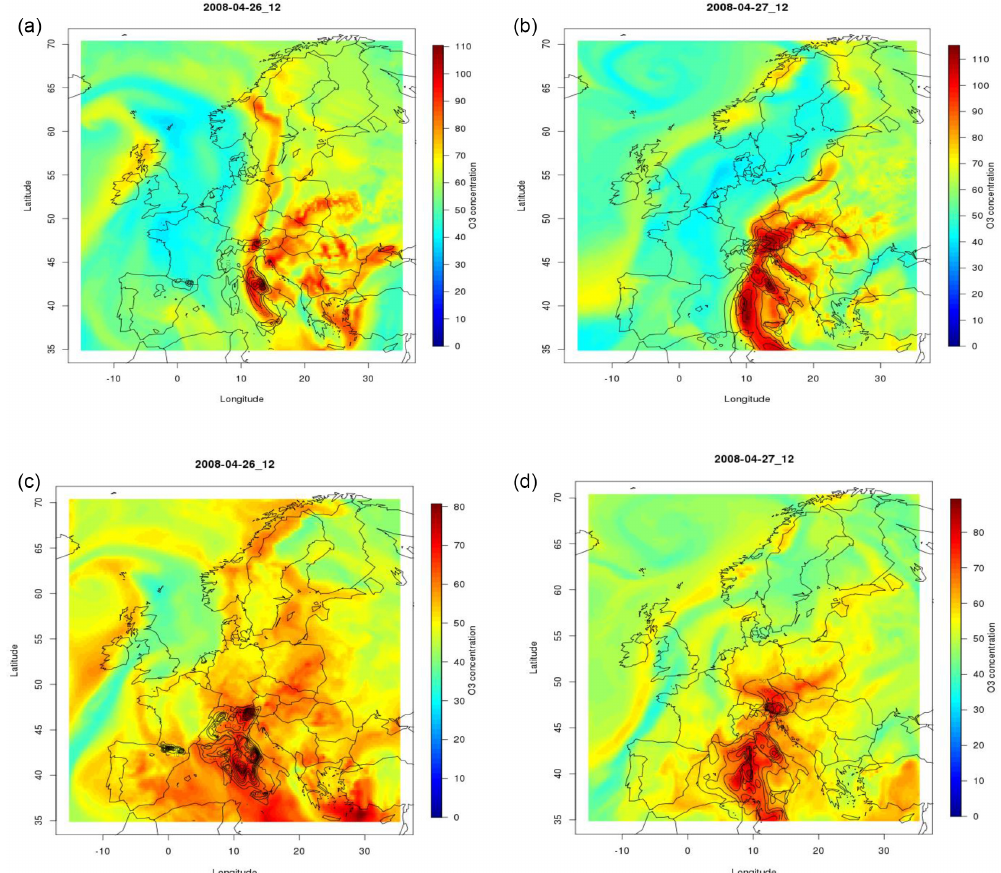
Figure 5. (a, b) CHIMERE simulations of the ozone field at 3km altitude (in ppb) with the iso-contours of the high tropospheric tracer (in black; arbitrary units) for 26 April 2008 (left column) and for 27 April 2008 (right column). (c, d) Same as in upper panels but for 1.5km